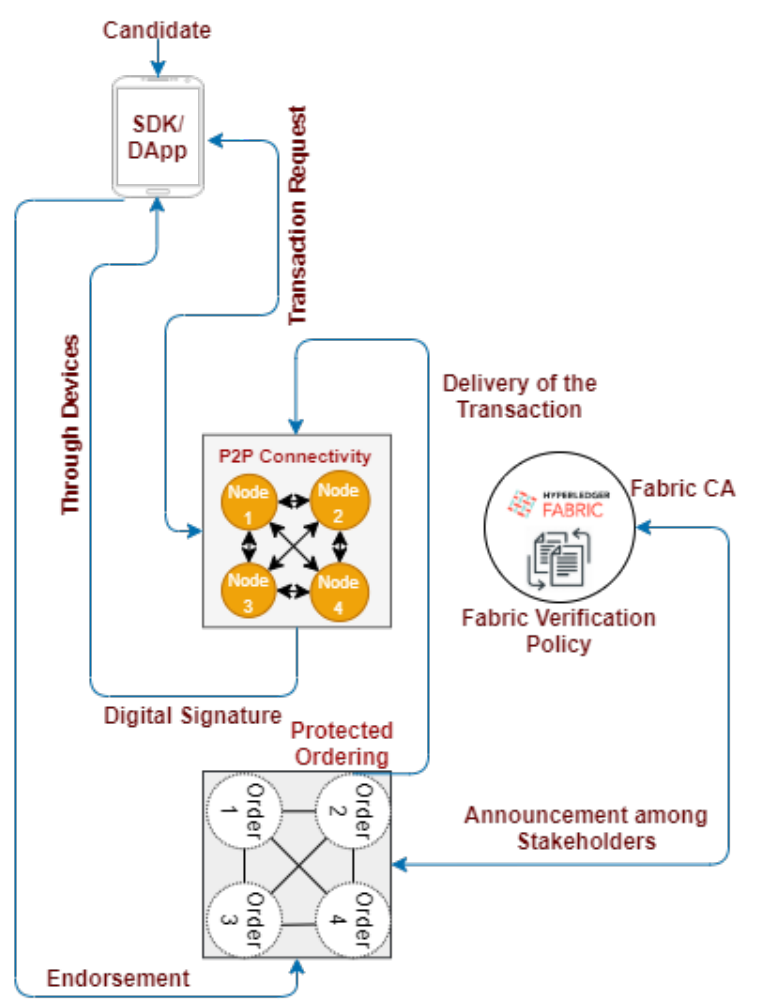
Figure 4. Implementation of block transactions execution process.